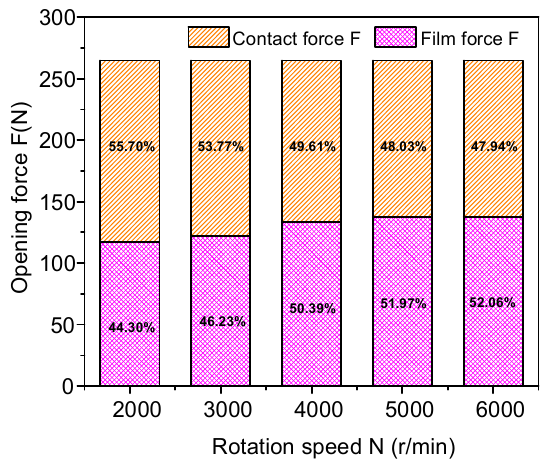
Figure 8. Proportion of the opening force.